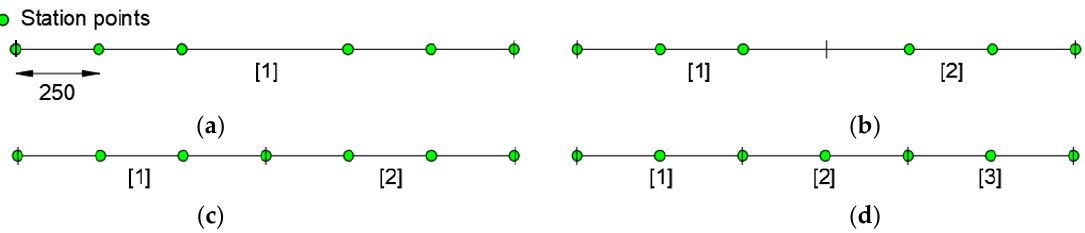
Figure 7. Modeling configuration: ( a ) one element with six station points; ( b ) two elements with three station points; ( c ) two elements with four station points; ( d ) three elements with three station points.